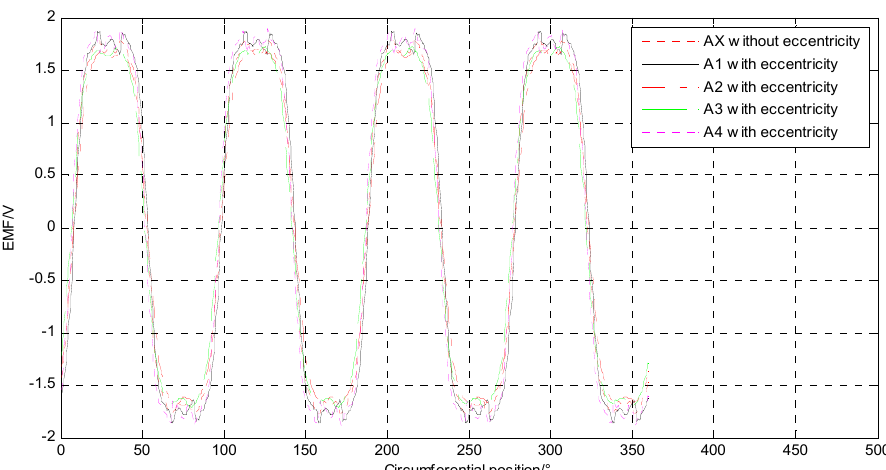
Figure 10. EMF of winding elements when the motor rotates once.